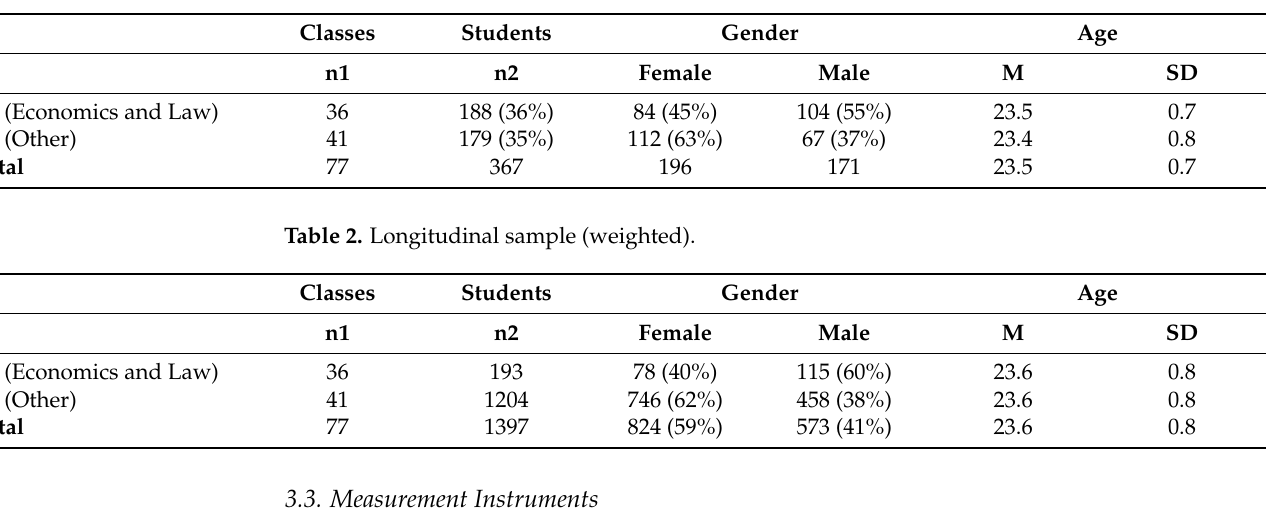
Table 1. Longitudinal sample (unweighted).